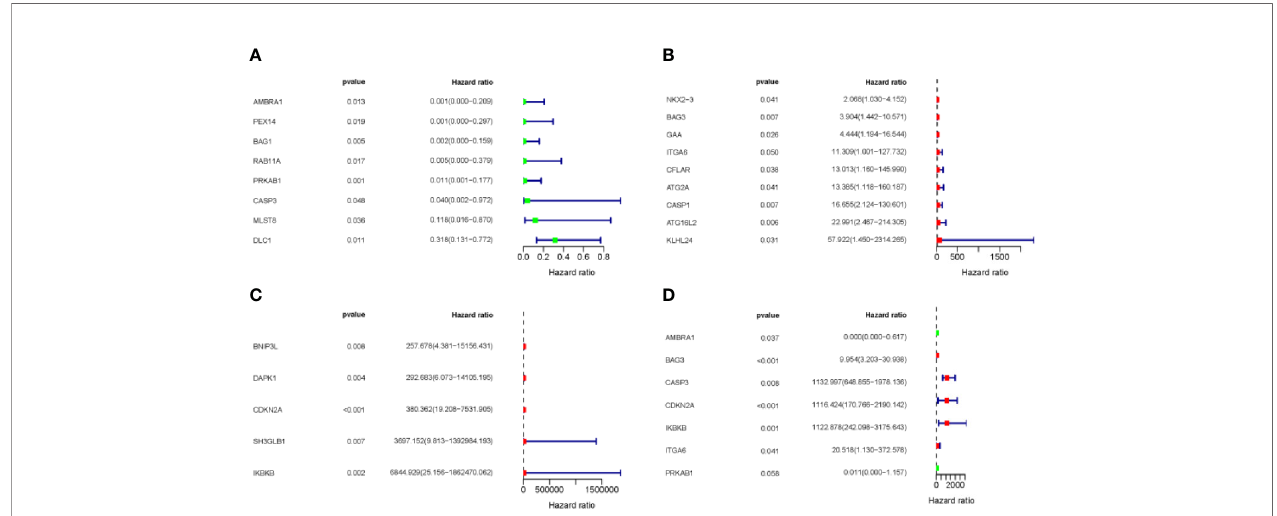
FIGURE 3 | Expression pro fi le and prognostic value of ARGs. (A – C) Univariate regression analysis. (D) Multivariate regression analysis. Red represents positively correlated with prognostic, and green represents negatively correlated